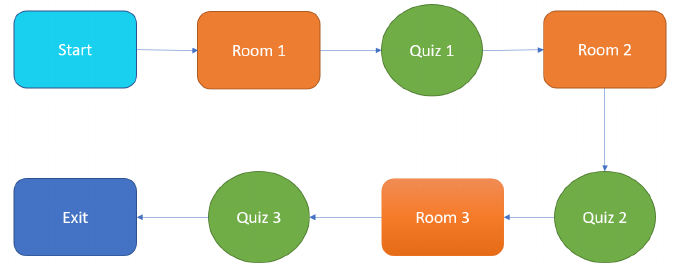
Figure 1. Basic scheme of an escape room to be played in